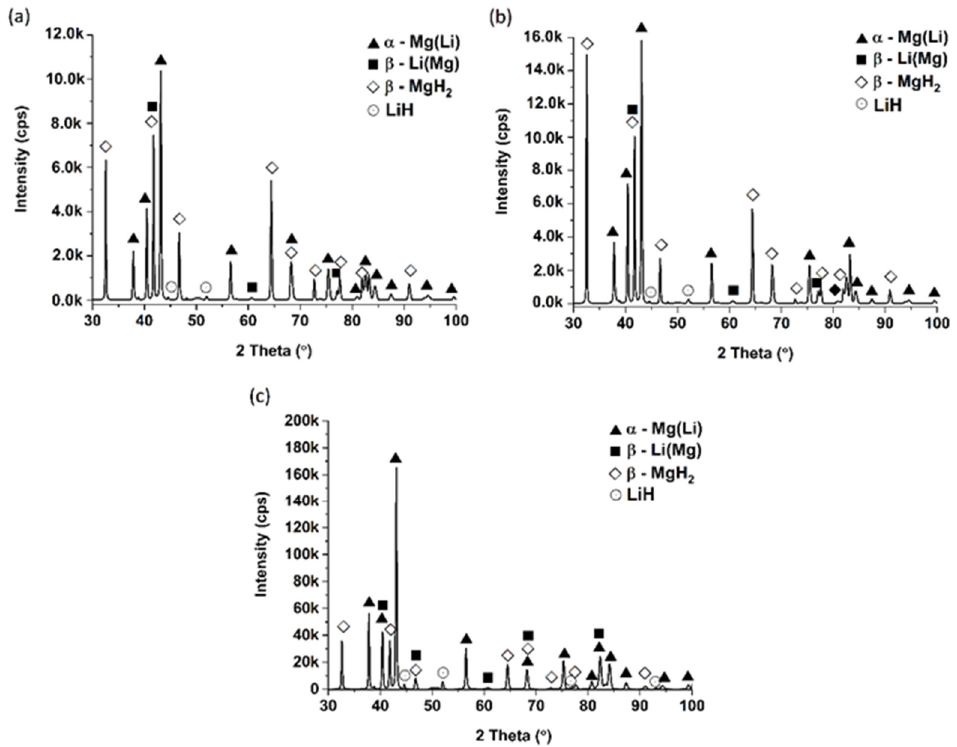
Figure 4. XRD pattern for the AZ31 alloy modified by 4.0 wt.% Li ( a ), 7.5 wt.% Li ( b ) and 15.0 wt.% Li ( c ) after hydrogenation.